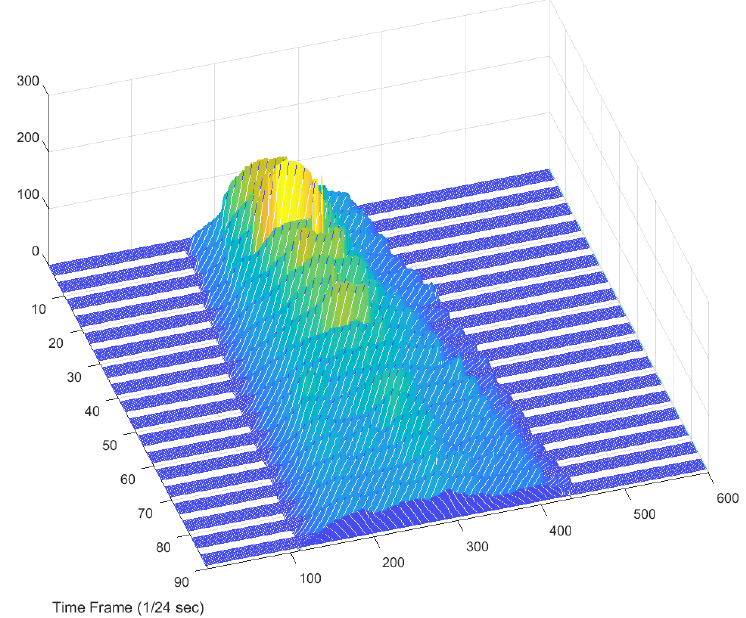
Figure 13. Visualization of spreading concrete cross-section during the slump flow test (3D surface representation).